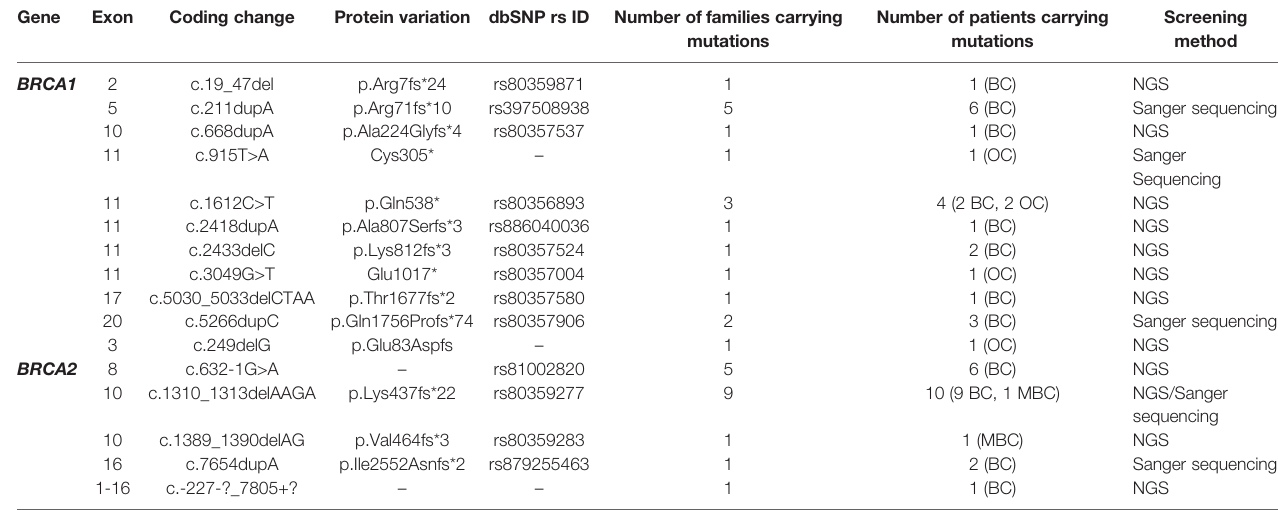
TABLE 1 | Mutations in the BRCA1/2 genes identi fi ed in breast cancer and ovarian cancer patients by Sanger and next generation sequencing technologies. Gene Exon Coding